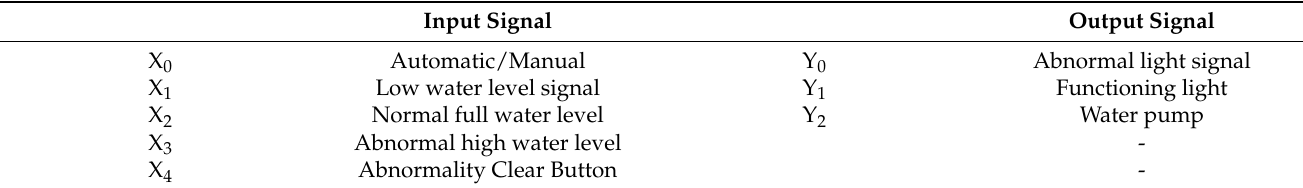
Table 3. Input and Output Signal Planning.